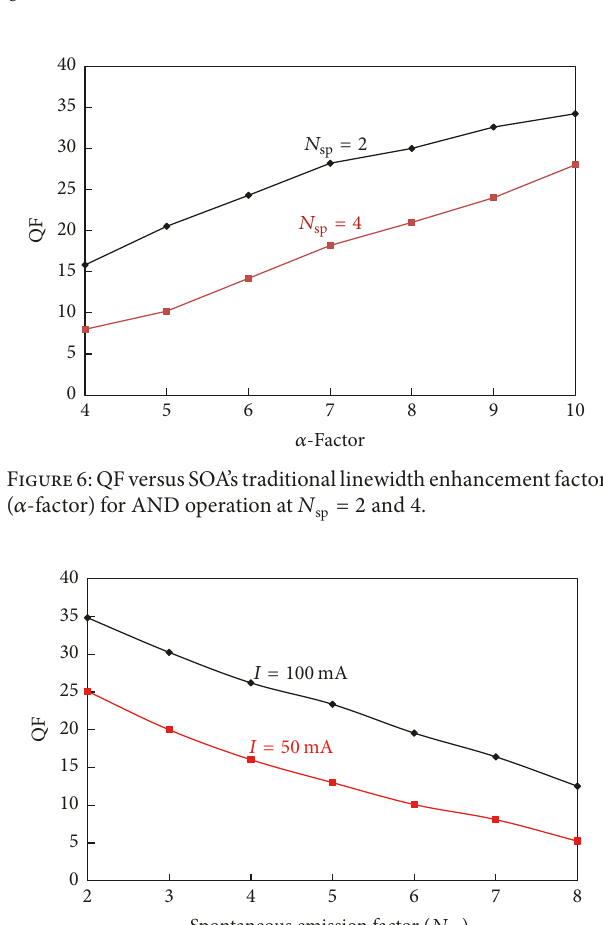
Figure 7: QF versus spontaneous emission factor (𝑁 MZI-based AND operation at 𝐼 = 50 mA and 100mA.